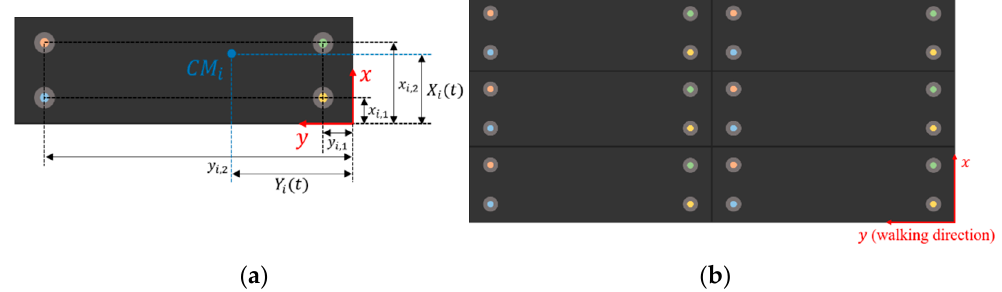
Figure 1. ( a ) Single gravimetric platform schematic; ( b ) Total gravimetric sensor (footboard) schematic.